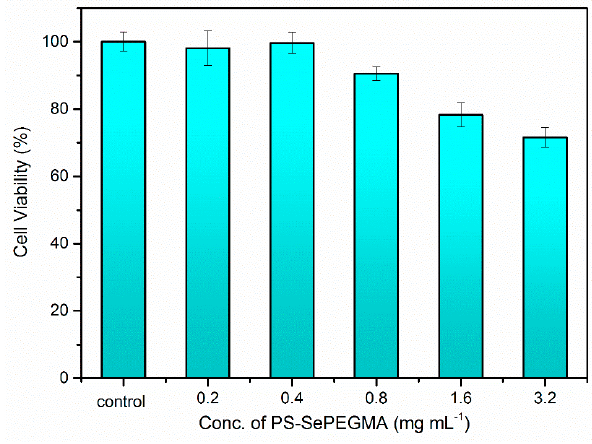
Figure 8. Cytotoxicity of PS-Se- b -PEGMA ( M n,SEC = 3700 g mol − 1 , Ɖ = 1.11) at different concentrations. The data are expressed as mean ± SD, where n =